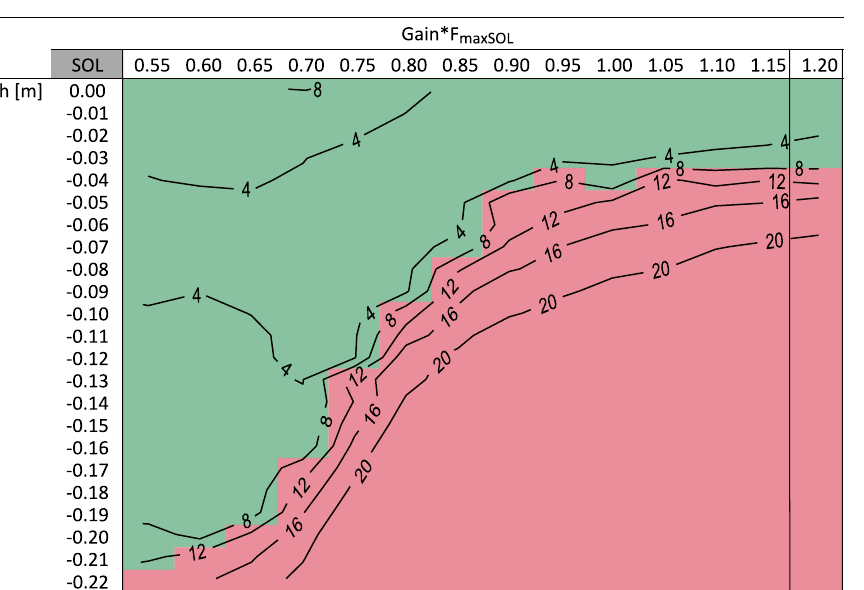
Figure 4. The figure shows successful (green) and unsuccessful (red) trials for various late anticipatory SOL gain adaptions and different perturbation heights h . Default settings of the gain, as previously described in Geyer et al. 13 , are indicated by vertical lines. Furthermore, contour lines can be seen in the figure to show in which area the calculated shift in margin of stability ΔS [cm] for each trial is located. For reasons of clarity, no further contour lines were drawn in the range of ΔS > 20